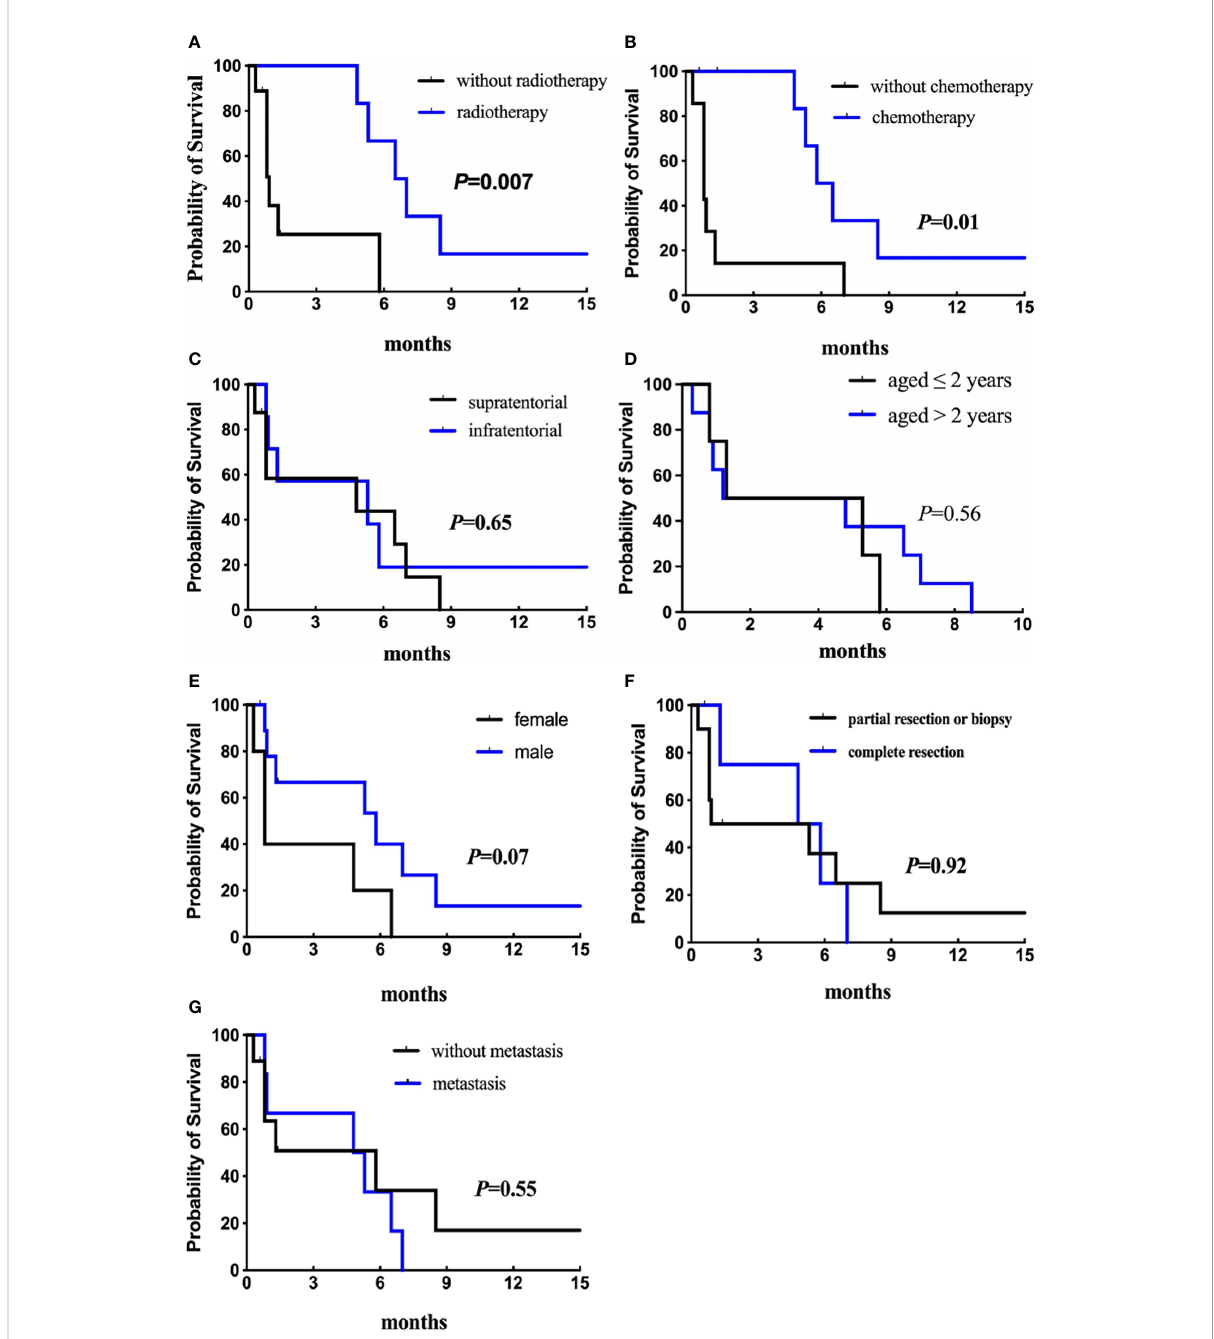
FIGURE 9 Analyses of event-free survival (Kaplan – Meier method) according to (A) radiotherapy ( p = 0.007); (B) chemotherapy ( p = 0.01); (C) primary tumor location ( p = 0.65); (D) age at diagnosis ( p = 0.56). Figure 9.2 Analyses of event-free survival (Kaplan – Meier method) according to (E) gender ( p = 0.07); (F) surgical resection ( p = 0.92); (G) metastatic status ( p =